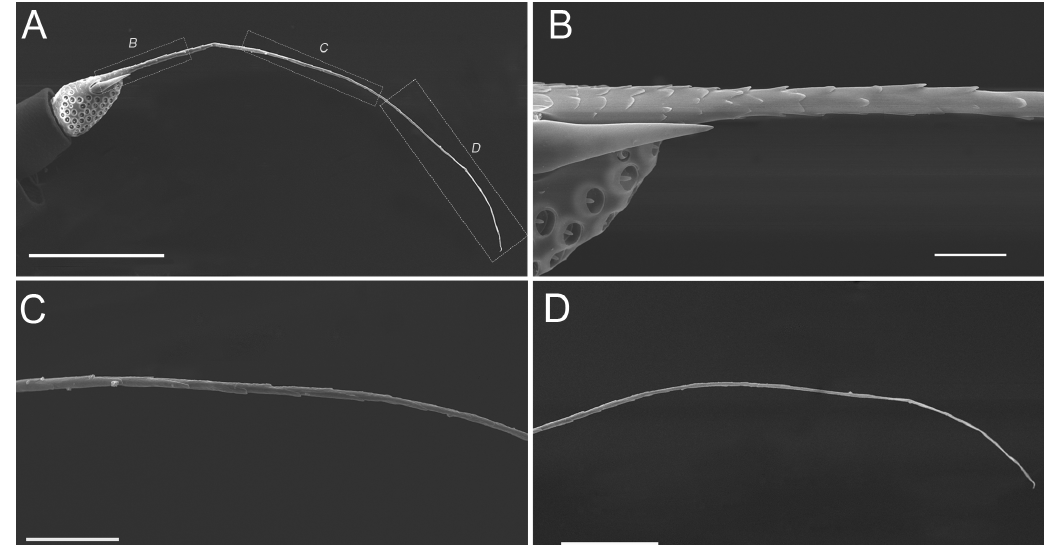
Figure 7. SEM micrographs showing the flagellum of an adult Callitettix versicolor (Fabricius). ( A ) Entire flagellum consisting of the bulb-shaped portion and apical arista; ( B ) High magnification image of the base showing apical arista covered with imbricate papillae; ( C ) High magnification image of the middle showing apical arista with imbricate papillae decreasing gradually; ( D ) High magnification image of apical half showing apical arista without imbricate papillae. Positions of images ( B ), ( C ) and ( D ) are indicated by lettered rectangles given in ( A ). Scale bars: A = 250 μm; B = 25 μm; C = 50 μm; D = 100 μm.